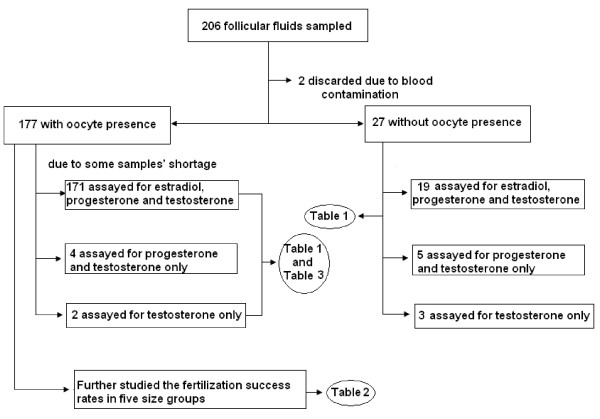
Samples and sample analysis. Consort-type diagram to show the sample distribution and numbers in the study analysis.